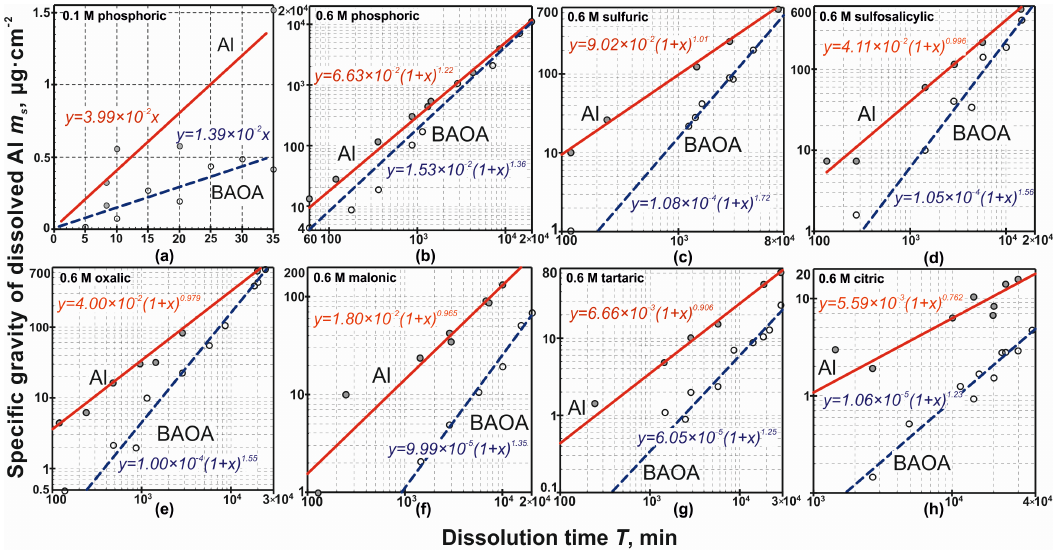
Figure 1. Dependence of the specific gravity of dissolved aluminum m s upon exposure to a 0.1 M solution of phosphoric acid ( a ) in 0.6 M solutions of phosphoric ( b ), sulfuric ( c ), sulfosalicylic ( d ), oxalic ( e ), malonic ( f ), tartaric ( g ), and citric ( h ) acids for unoxidized aluminum (solid, red line) and aluminum protected by barrier anodic oxide on aluminum (BAOA) (dashed, blue line).